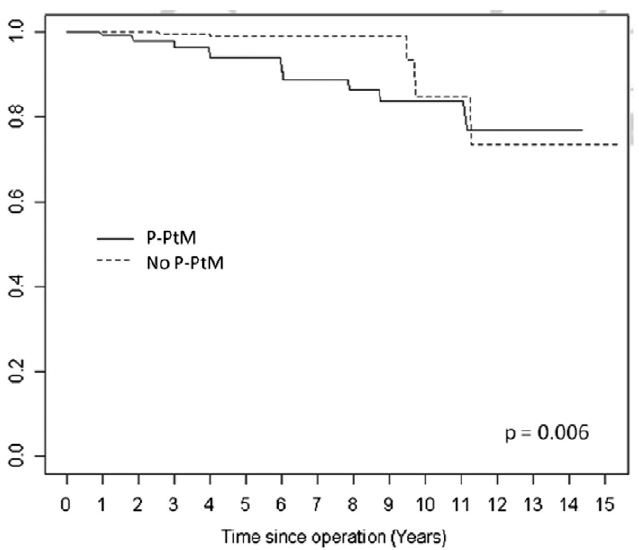
Figure. 10 Freedom from structural valve deterioration (SVD) since for patients with and without prosthesis- patient mismatch (P-PtM). (Reproduced and modified with permission from